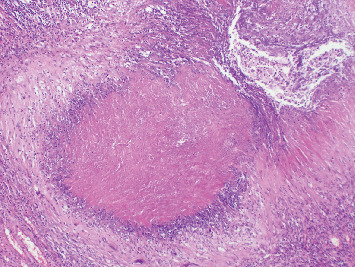
Nongranulomatous necrotic nodule, H&E, ×40.